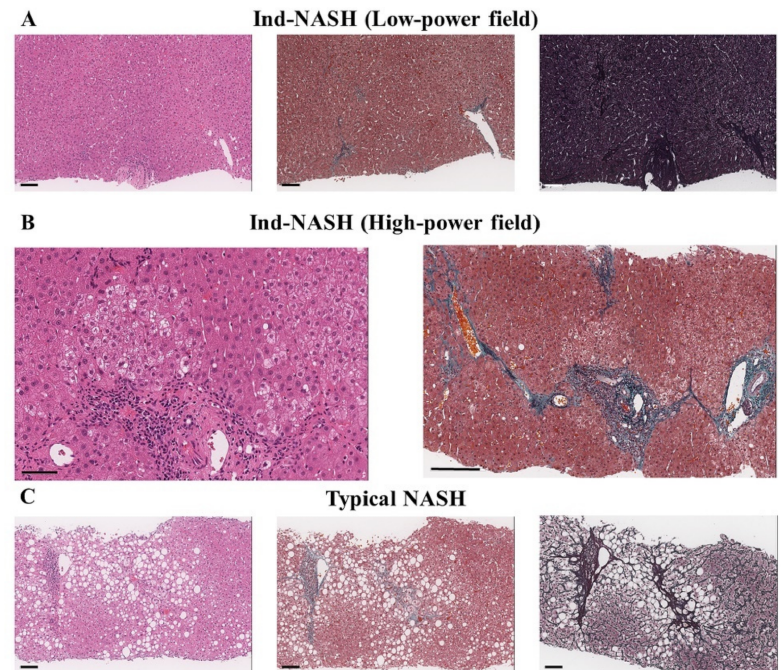
Figure 1. Histopathological differences between Ind-NASH and typical NASH. Microscopic findings are shown as hematoxylin–eosin, Masson trichrome, and silver reticulin from the left to right. ( A ) A typical Ind-NASH patient with a low-power field view. Small bars represent 100 µ m. Mild steatosis and mild abnormal fibrosis around central veins are seen. ( B ) Focal ballooning in an Ind-NASH patient (left). Small bar represents 60 µ m. Central vein fibrosis without steatosis (right). Small bar represents 200 µ m. ( C ) A typical NASH patient. Small bars represent 100 µ m. Severe steatosis, hepatocyte ballooning, and periportal fibrosis are